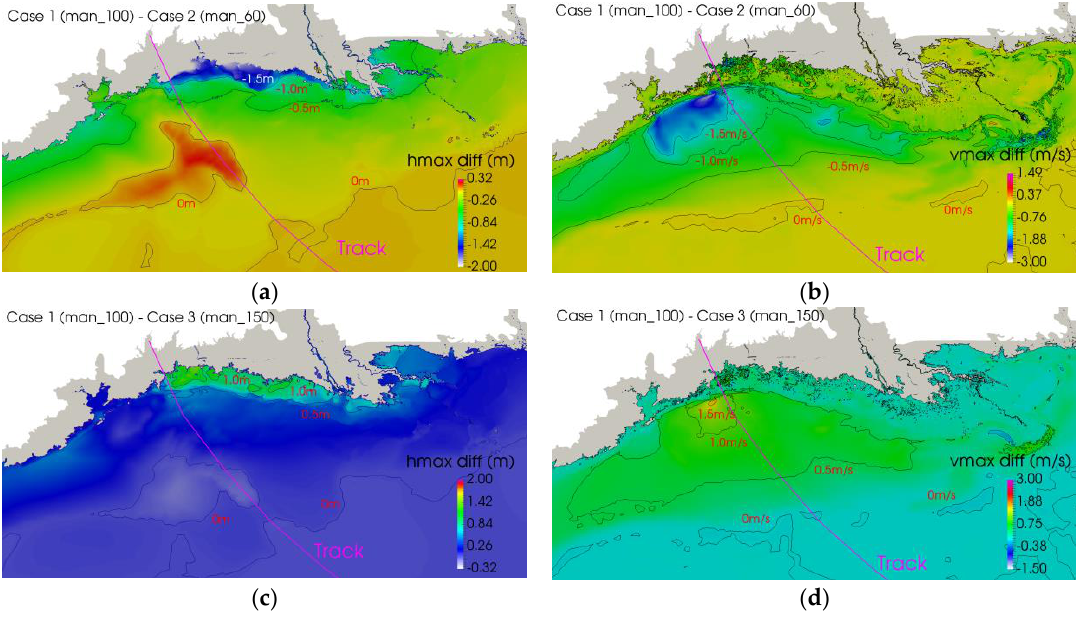
Figure 4. Contour plots of maximum water elevation and velocity differences for hindcast of Hurricane Rita storm surges. ( a ) maximum elevation difference: Case 1–Case 2; ( b ) maximum velocity difference: Case 1–Case 2; ( c ) maximum elevation difference: Case 1–Case 3; ( d ) maximum velocity difference: Case 1–Case